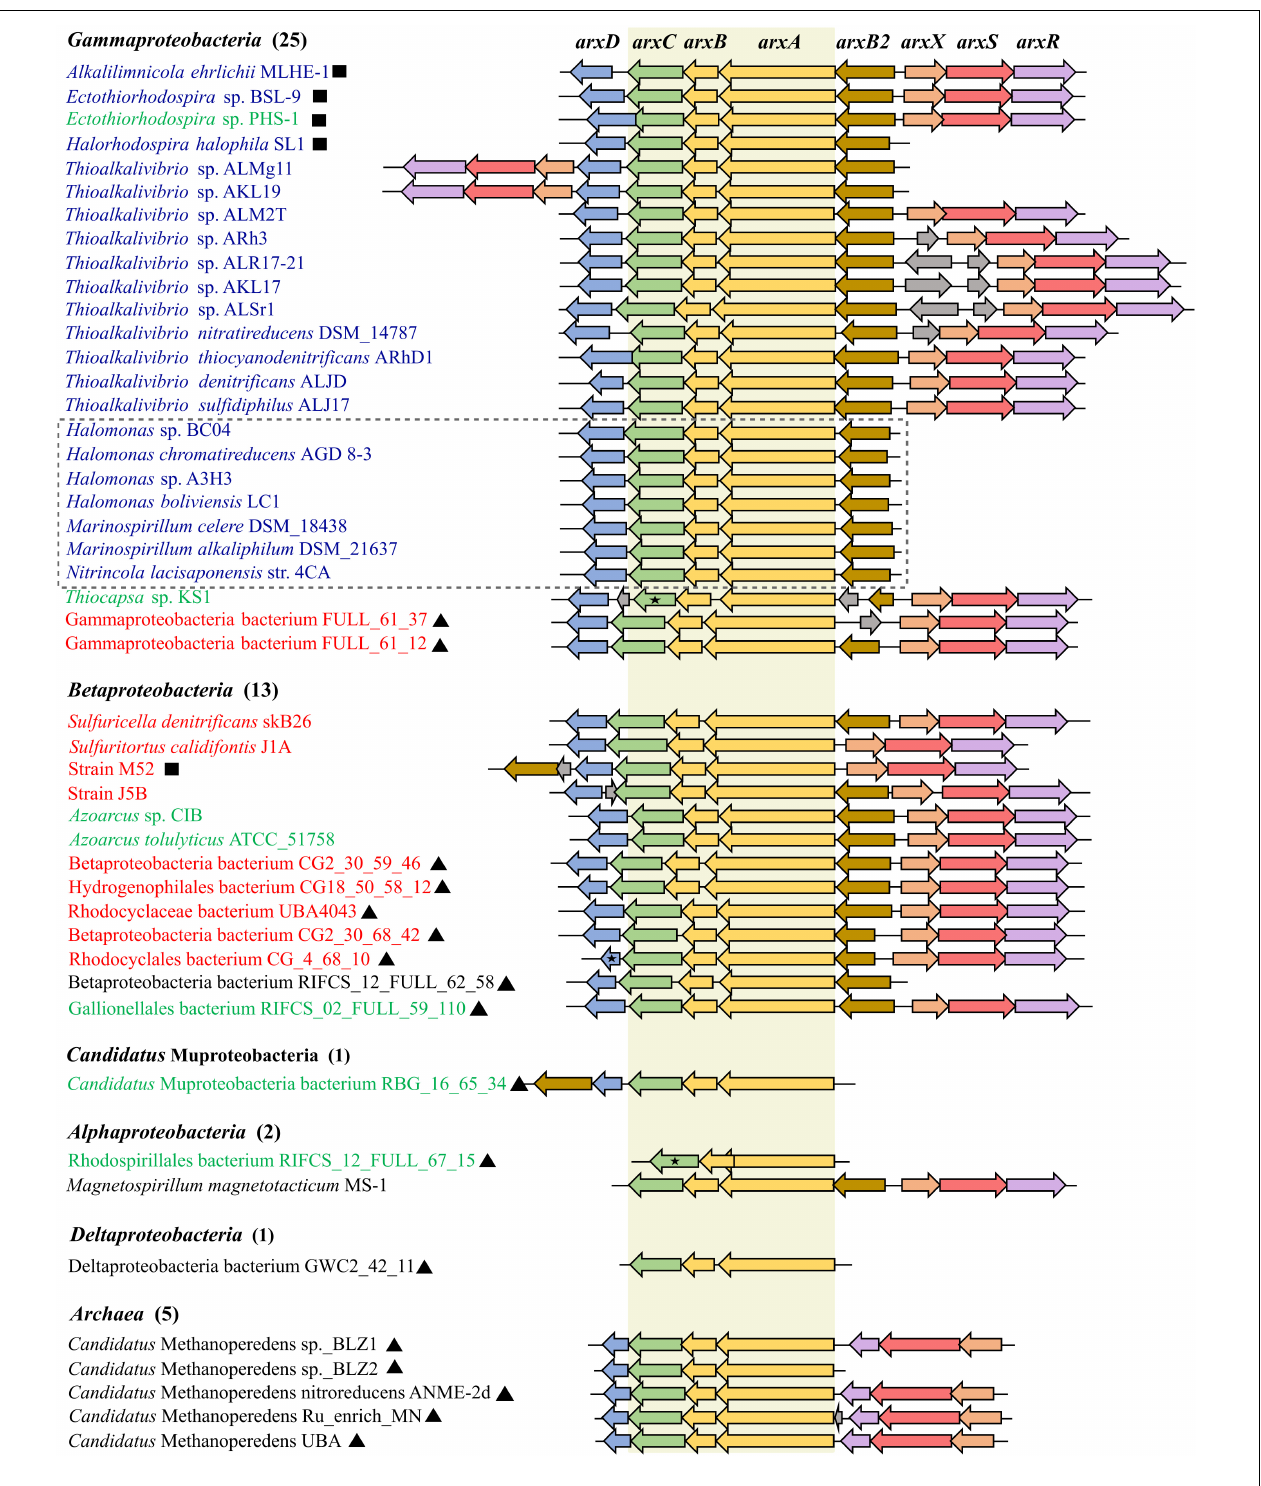
FIGURE 4 | Arrangement of the arx gene cluster found in the genomes. Arrows with different colors represent the following genes: yellow for arxAB , green for arxC , blue for arxD , gold for arxB2 , peach for arxX , coral for arxS , purple for arxR , and gray for hypothetical proteins. The number of genomes for each class-level taxonomy of bacteria is shown in parentheses. Name of organisms with ARX of group 1, group 2, and group 3 are shown in blue, green and red respectively. Names with black square correspond to organism reported as arx -arsenite-oxidizing bacterium, including strain M52. Names with black triangle represent the metagenome-assembled genomes (MAGs). Black star represents the genes encoding products annotated as partial protein. Names of organisms affiliated to the Order Oceanospirillum are enclosed in a gray dashed square. The conserved arxABC genes are highlighted in beige color.